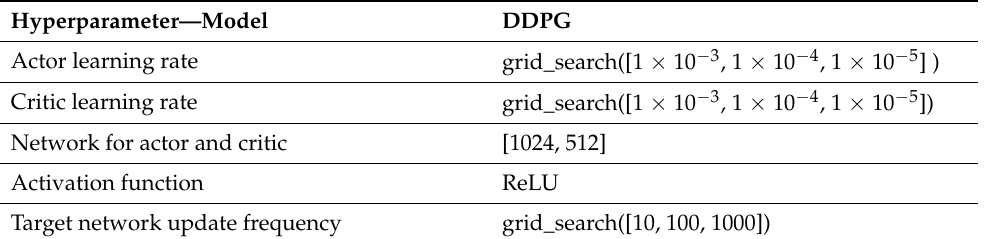
Table 5. Hyperparameters for the DDPG